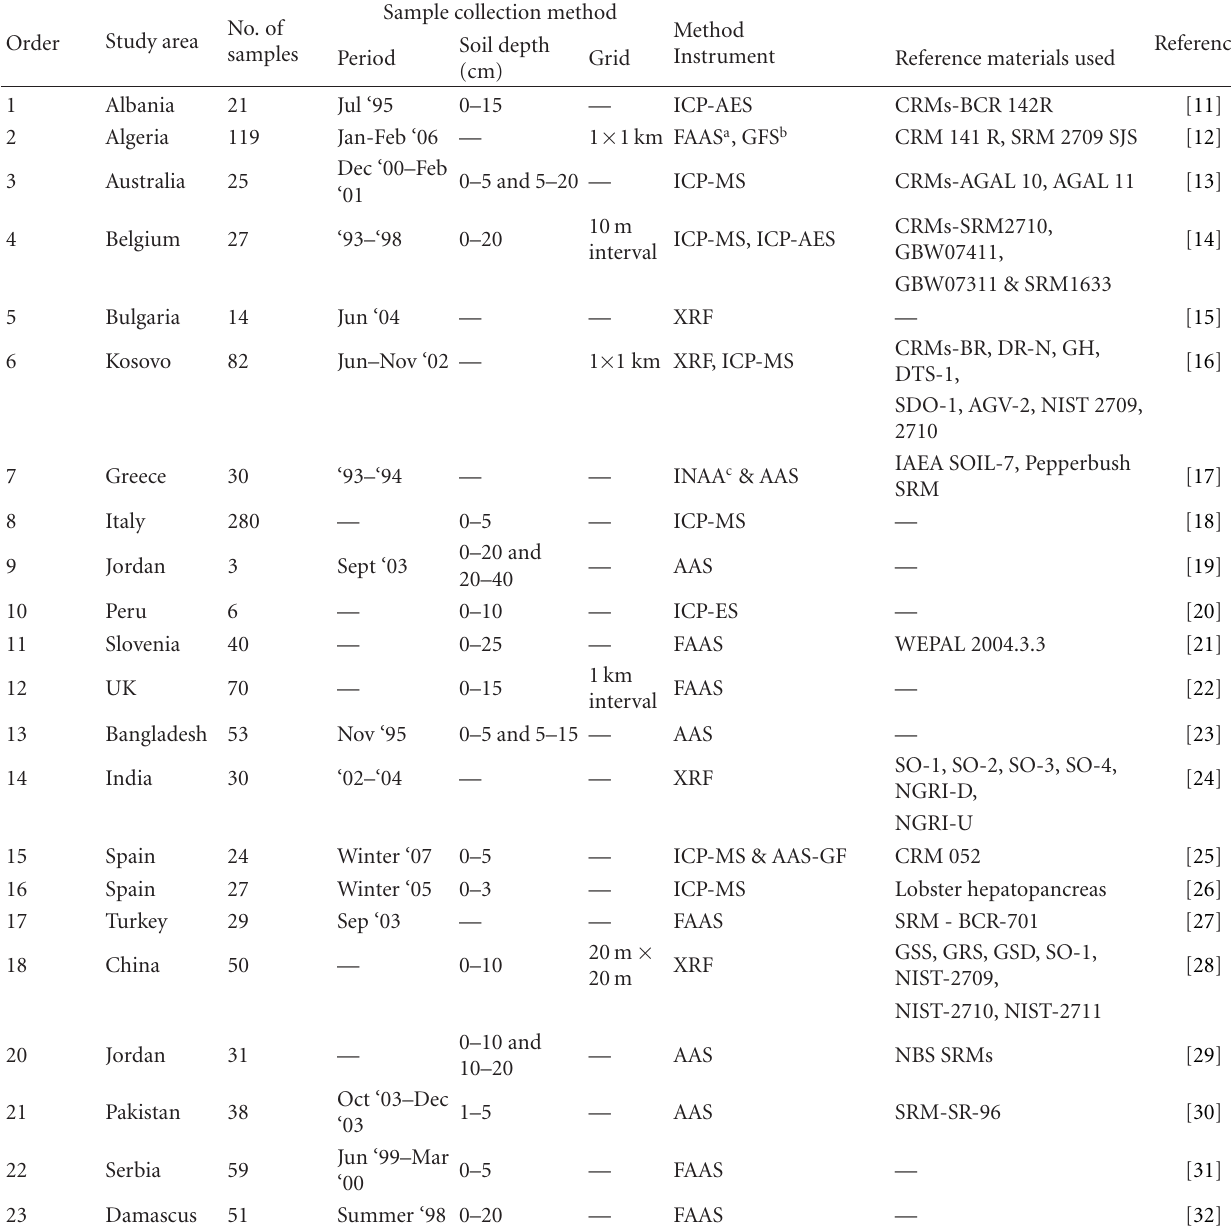
Table 2: Sampling and analytical procedures of metals in soil matrix reported between di ff erent